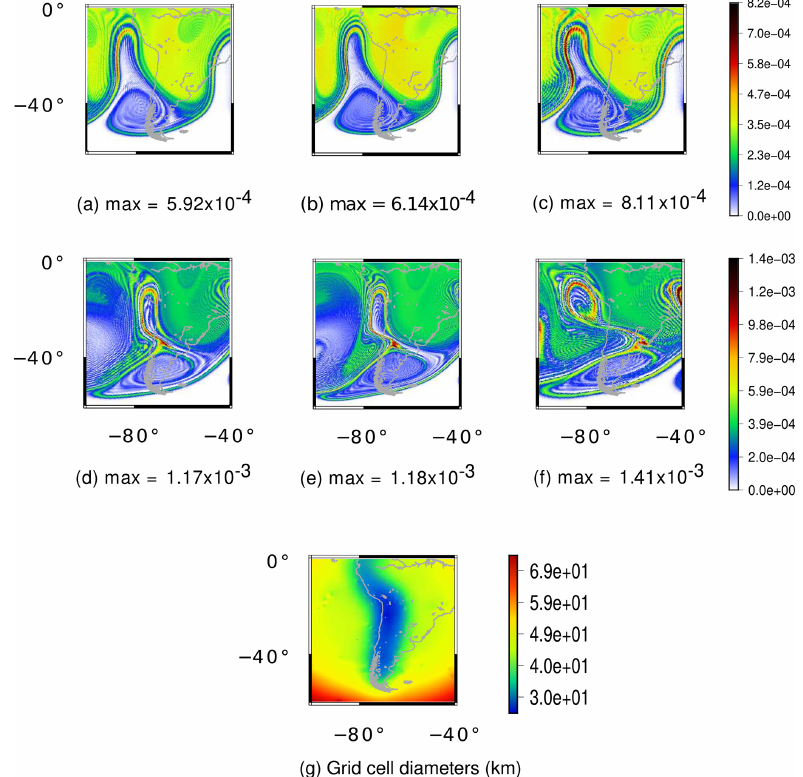
Figure 22. Unstable barotropic jet test case for the moist shallow-water model. (a–c) Rain field at day 7 for the UR8, UR9 and VR7 grids, respectively. (d–f) Rain field at day 8 for the UR8, UR9 and VR7 grids, respectively. (g) Grid cell diameters in kilometers for the VR7 grid. The UR8 and UR9 grids have an average resolution of 30 and 15km,